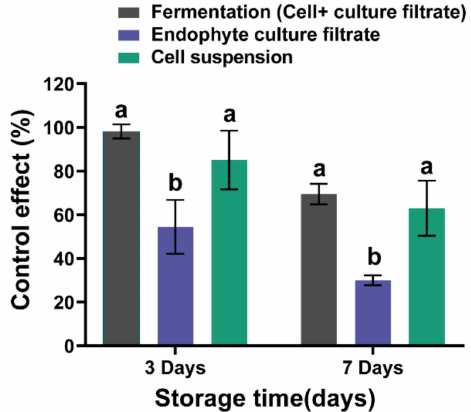
Figure 4. In vivo effects of different treatments of Bacillus subtilis L1-21 on citrus fruit. Different letters indicated a significant difference within the same time point according to the Duncan’s multiple range test ( p <